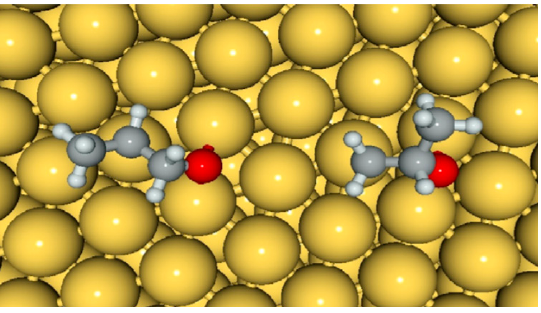
Figure 8. Structures of oxametallacycle intermediates: OMMP1 (left) and OMMP2 (right) on Au(111) [120]. Copyright © 2009 Elsevier B.V.